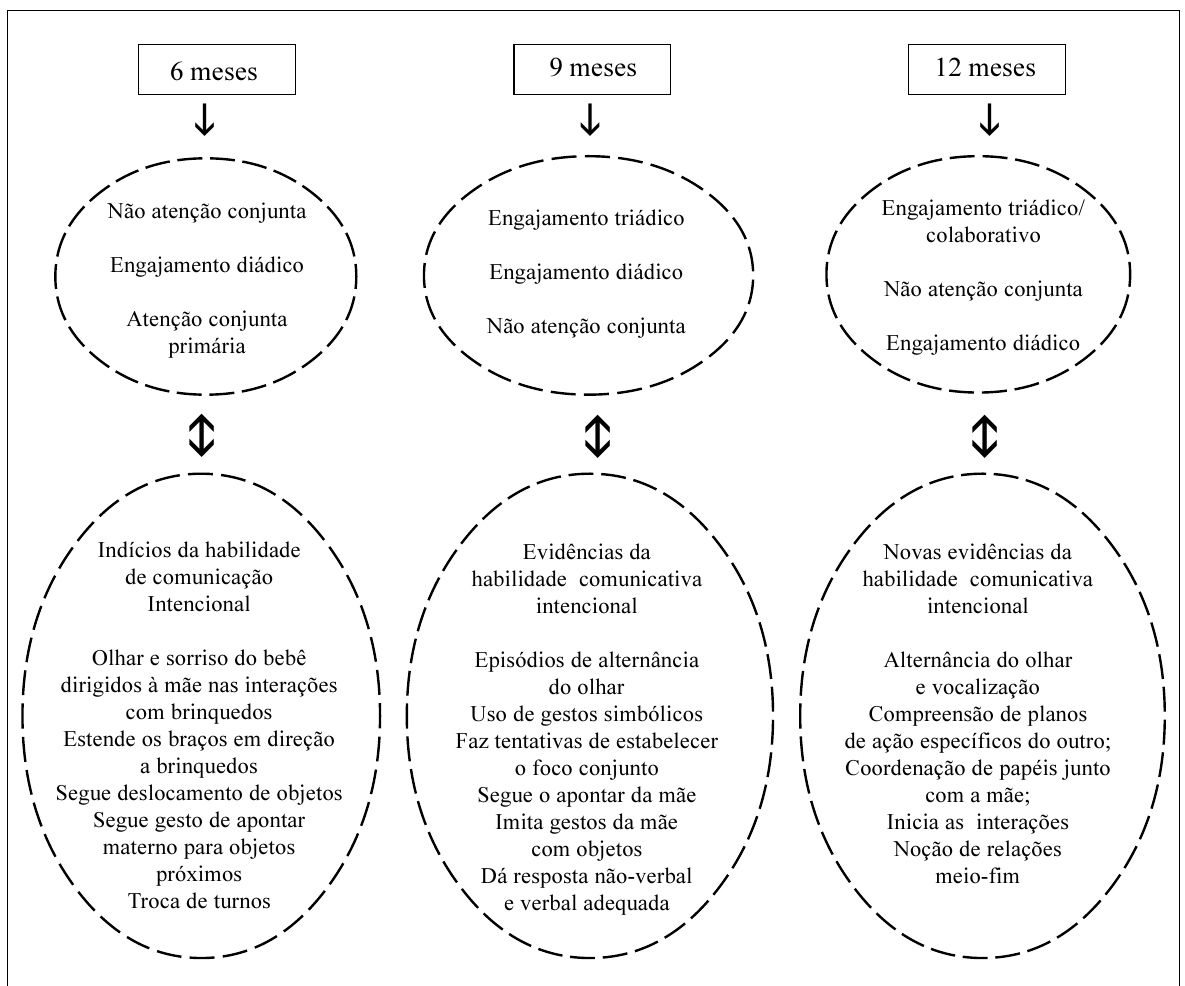
Figura 1 . Diagrama das configurações de atenção conjunta e habilidades comunicativas intencionais das díades mãe-bebê, nos três períodos evolutivos